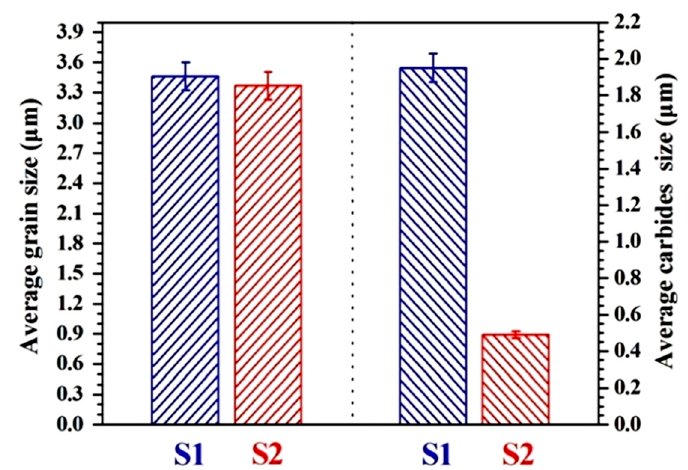
Figure 3. Average size of the layer matrix grains and carbides in the two cladding layers.